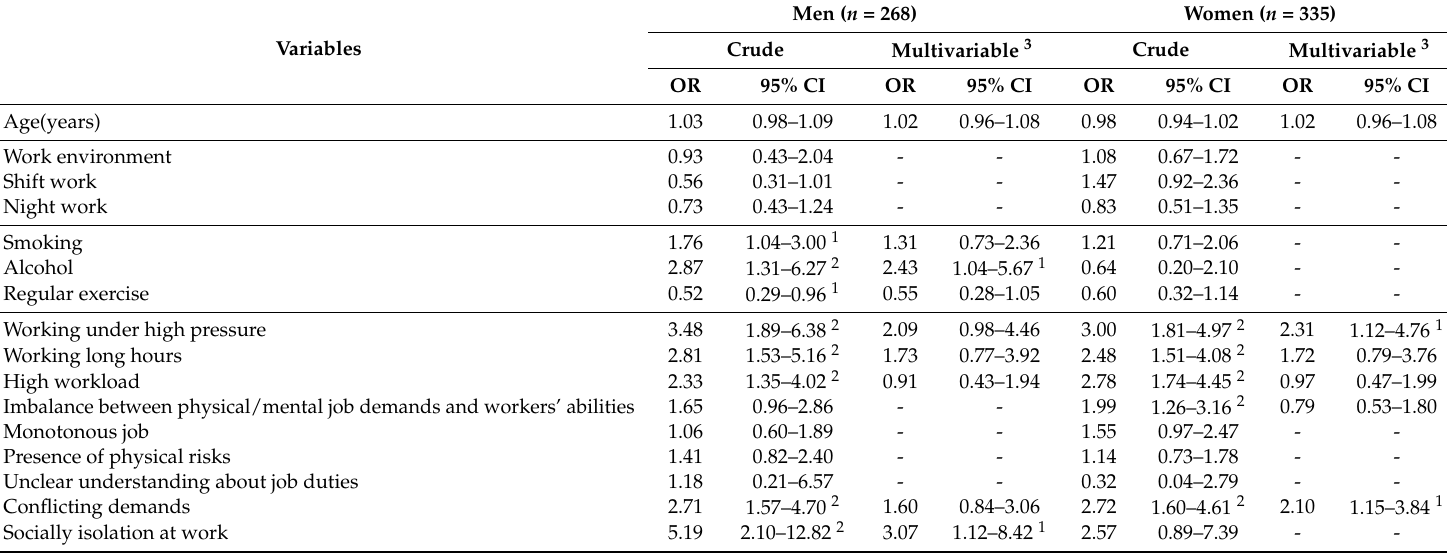
Table 4. Univariate and multivariate logistic regression analysis of factors influencing emotional symptoms, stratified by